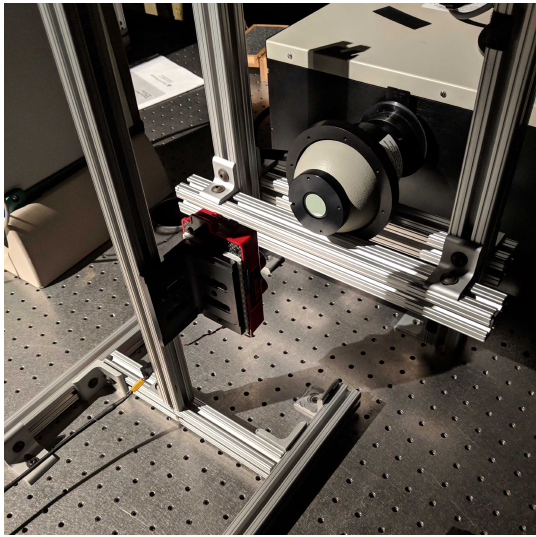
Figure 4. Relative spectral response curve data capture setup. Monochromator exit port connected to mini integrating sphere. RedEdge-3’s center lens is aligned with exit port of mini sphere. RedEdge-3 is attached to a custom made rig which allowed for both lateral and vertical